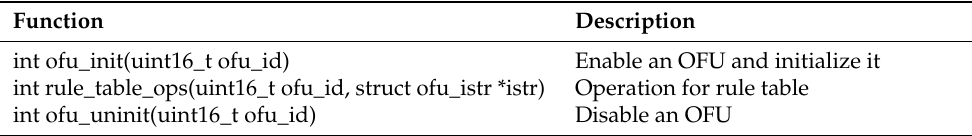
Table 2. Offered API and